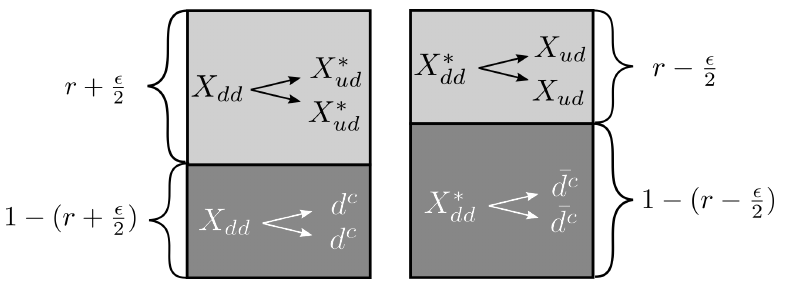
Figure 8 . Comparison of the different branching ratios of the X dd decay